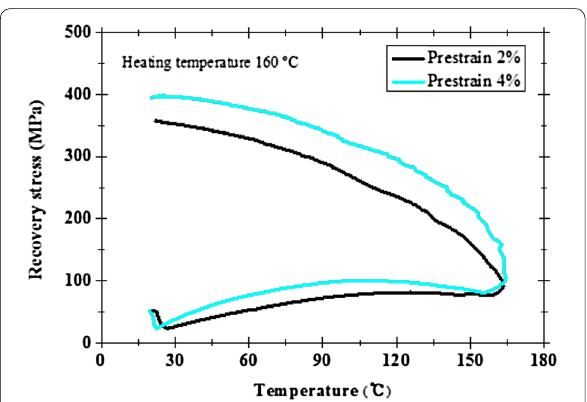
Fig. 4 Recovery stress–temperature curve of exposed